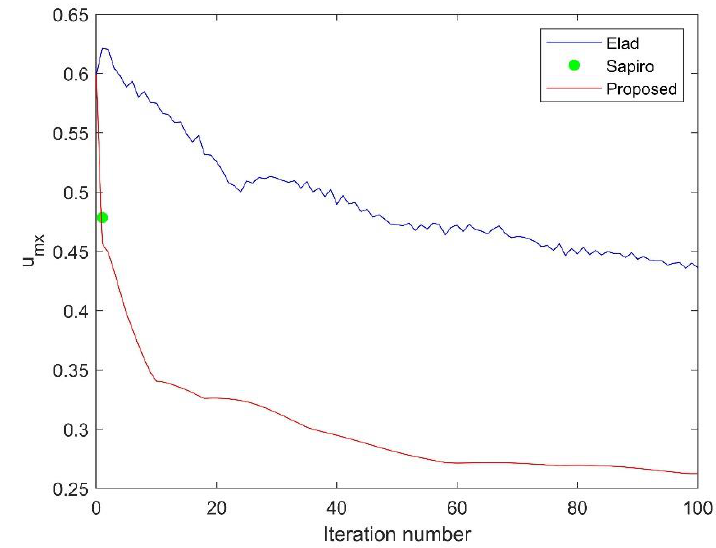
Figure 2. Histogram of the absolute off-diagonal entries of the corresponding normalized Gram matrix to each of the four sensing matrices.